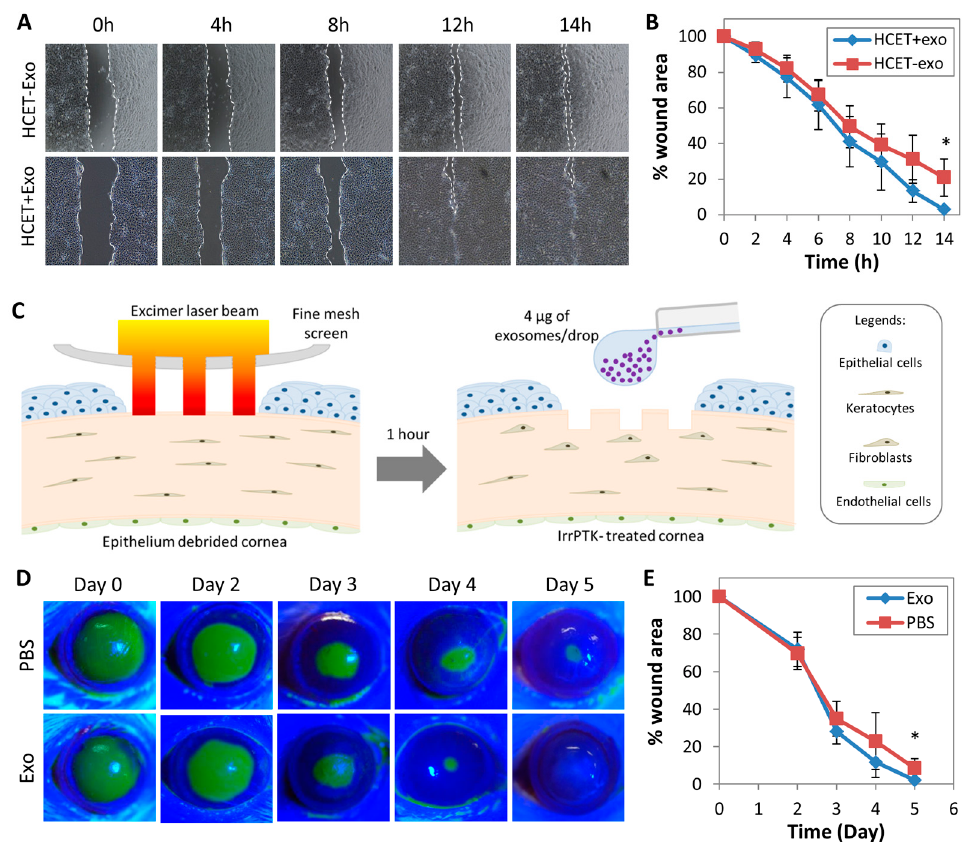
Figure 3. The effects of MSC-exo treatment on epithelial wound healing. ( A ) In vitro scratch wound assay on HCET culture showed that MSC-exo treatment induced a faster closure of denuded gap (upper panel) than the control group (lower panel). Photos were taken at 50 × magnification. ( B ) Percentage changes of denuded gap area revealed a more rapid cell proliferation and migration into the wound area over 14 h by MSC-exo treatment. ( C ) Schematic illustrations of the corneal injury caused by irregular phototherapeutic keratectomy (irrPTK). Following the mechanical debridement of the corneal epithelium, excimer laser ablation was applied to the Bowman’s membrane and anterior stroma. Stromal irregularities were created by placing a fine screen mesh in the laser path. ( D ) Fluorescein staining of injured corneas revealed the different extent of epithelial wound closure after MSC-exo treatment versus PBS. ( E ) Percentage changes of wound area after MSC-exo versus PBS treatments. The wound closure was greater on day 5 after MSC-exo treatment. * p < 0.05.